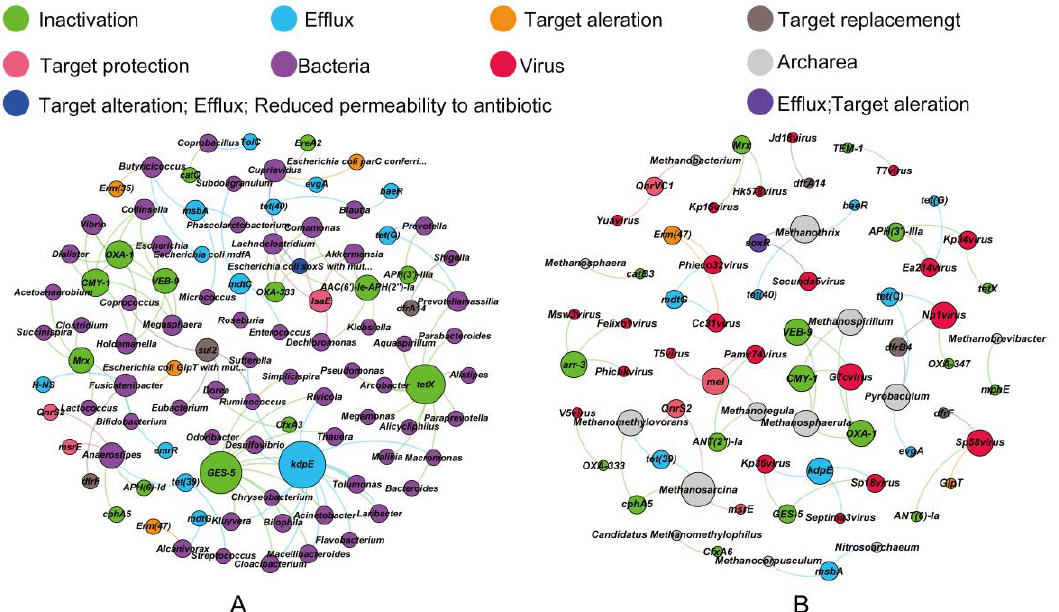
Figure 6. ARGs and microbial co-occurrence network based on correlation analysis, visualized by Gephi 0.9. Nodes represent ARG subtypes or species, and lines represent p -values < 0.05 and a strong correlation. The size of a node is proportional to its number of connections. Nodes are colored by the type of resistance mechanism of ARG subtypes and by the type of microorganism. Bacterial and ARG co-occurrence network ( A ). ( B ) Archaeal co-occurrence network with viruses and ARGs. Therefore, Methanosarcina needs to be focused on as a potential ARG host. Bacterio-